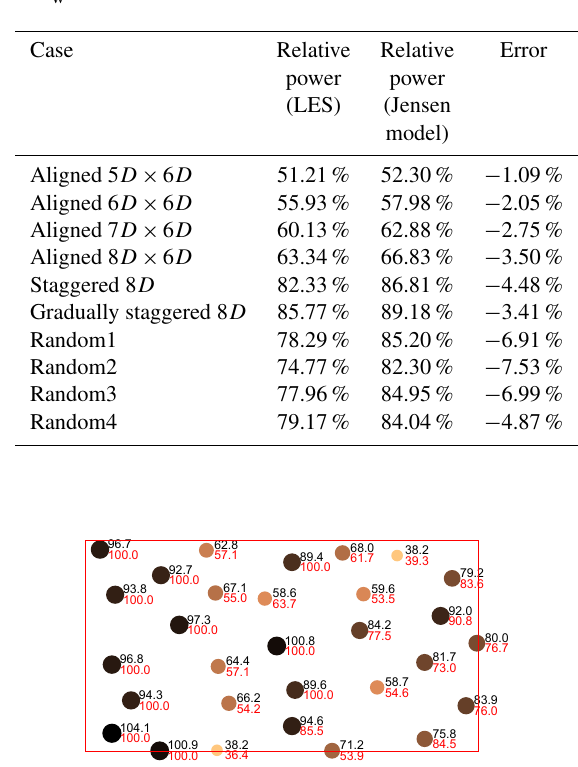
Table 3. Comparing outputs of LES and the Jensen wake model with k w = 0.060.